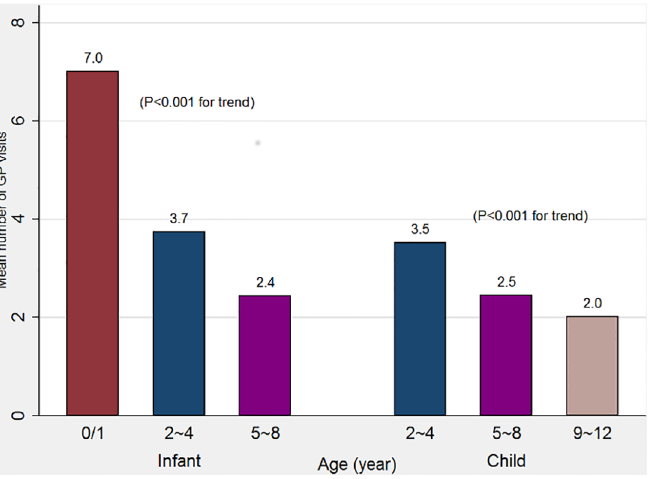
Fig 1. Mean number of annually GP visits for children in different age periods, by cohort.